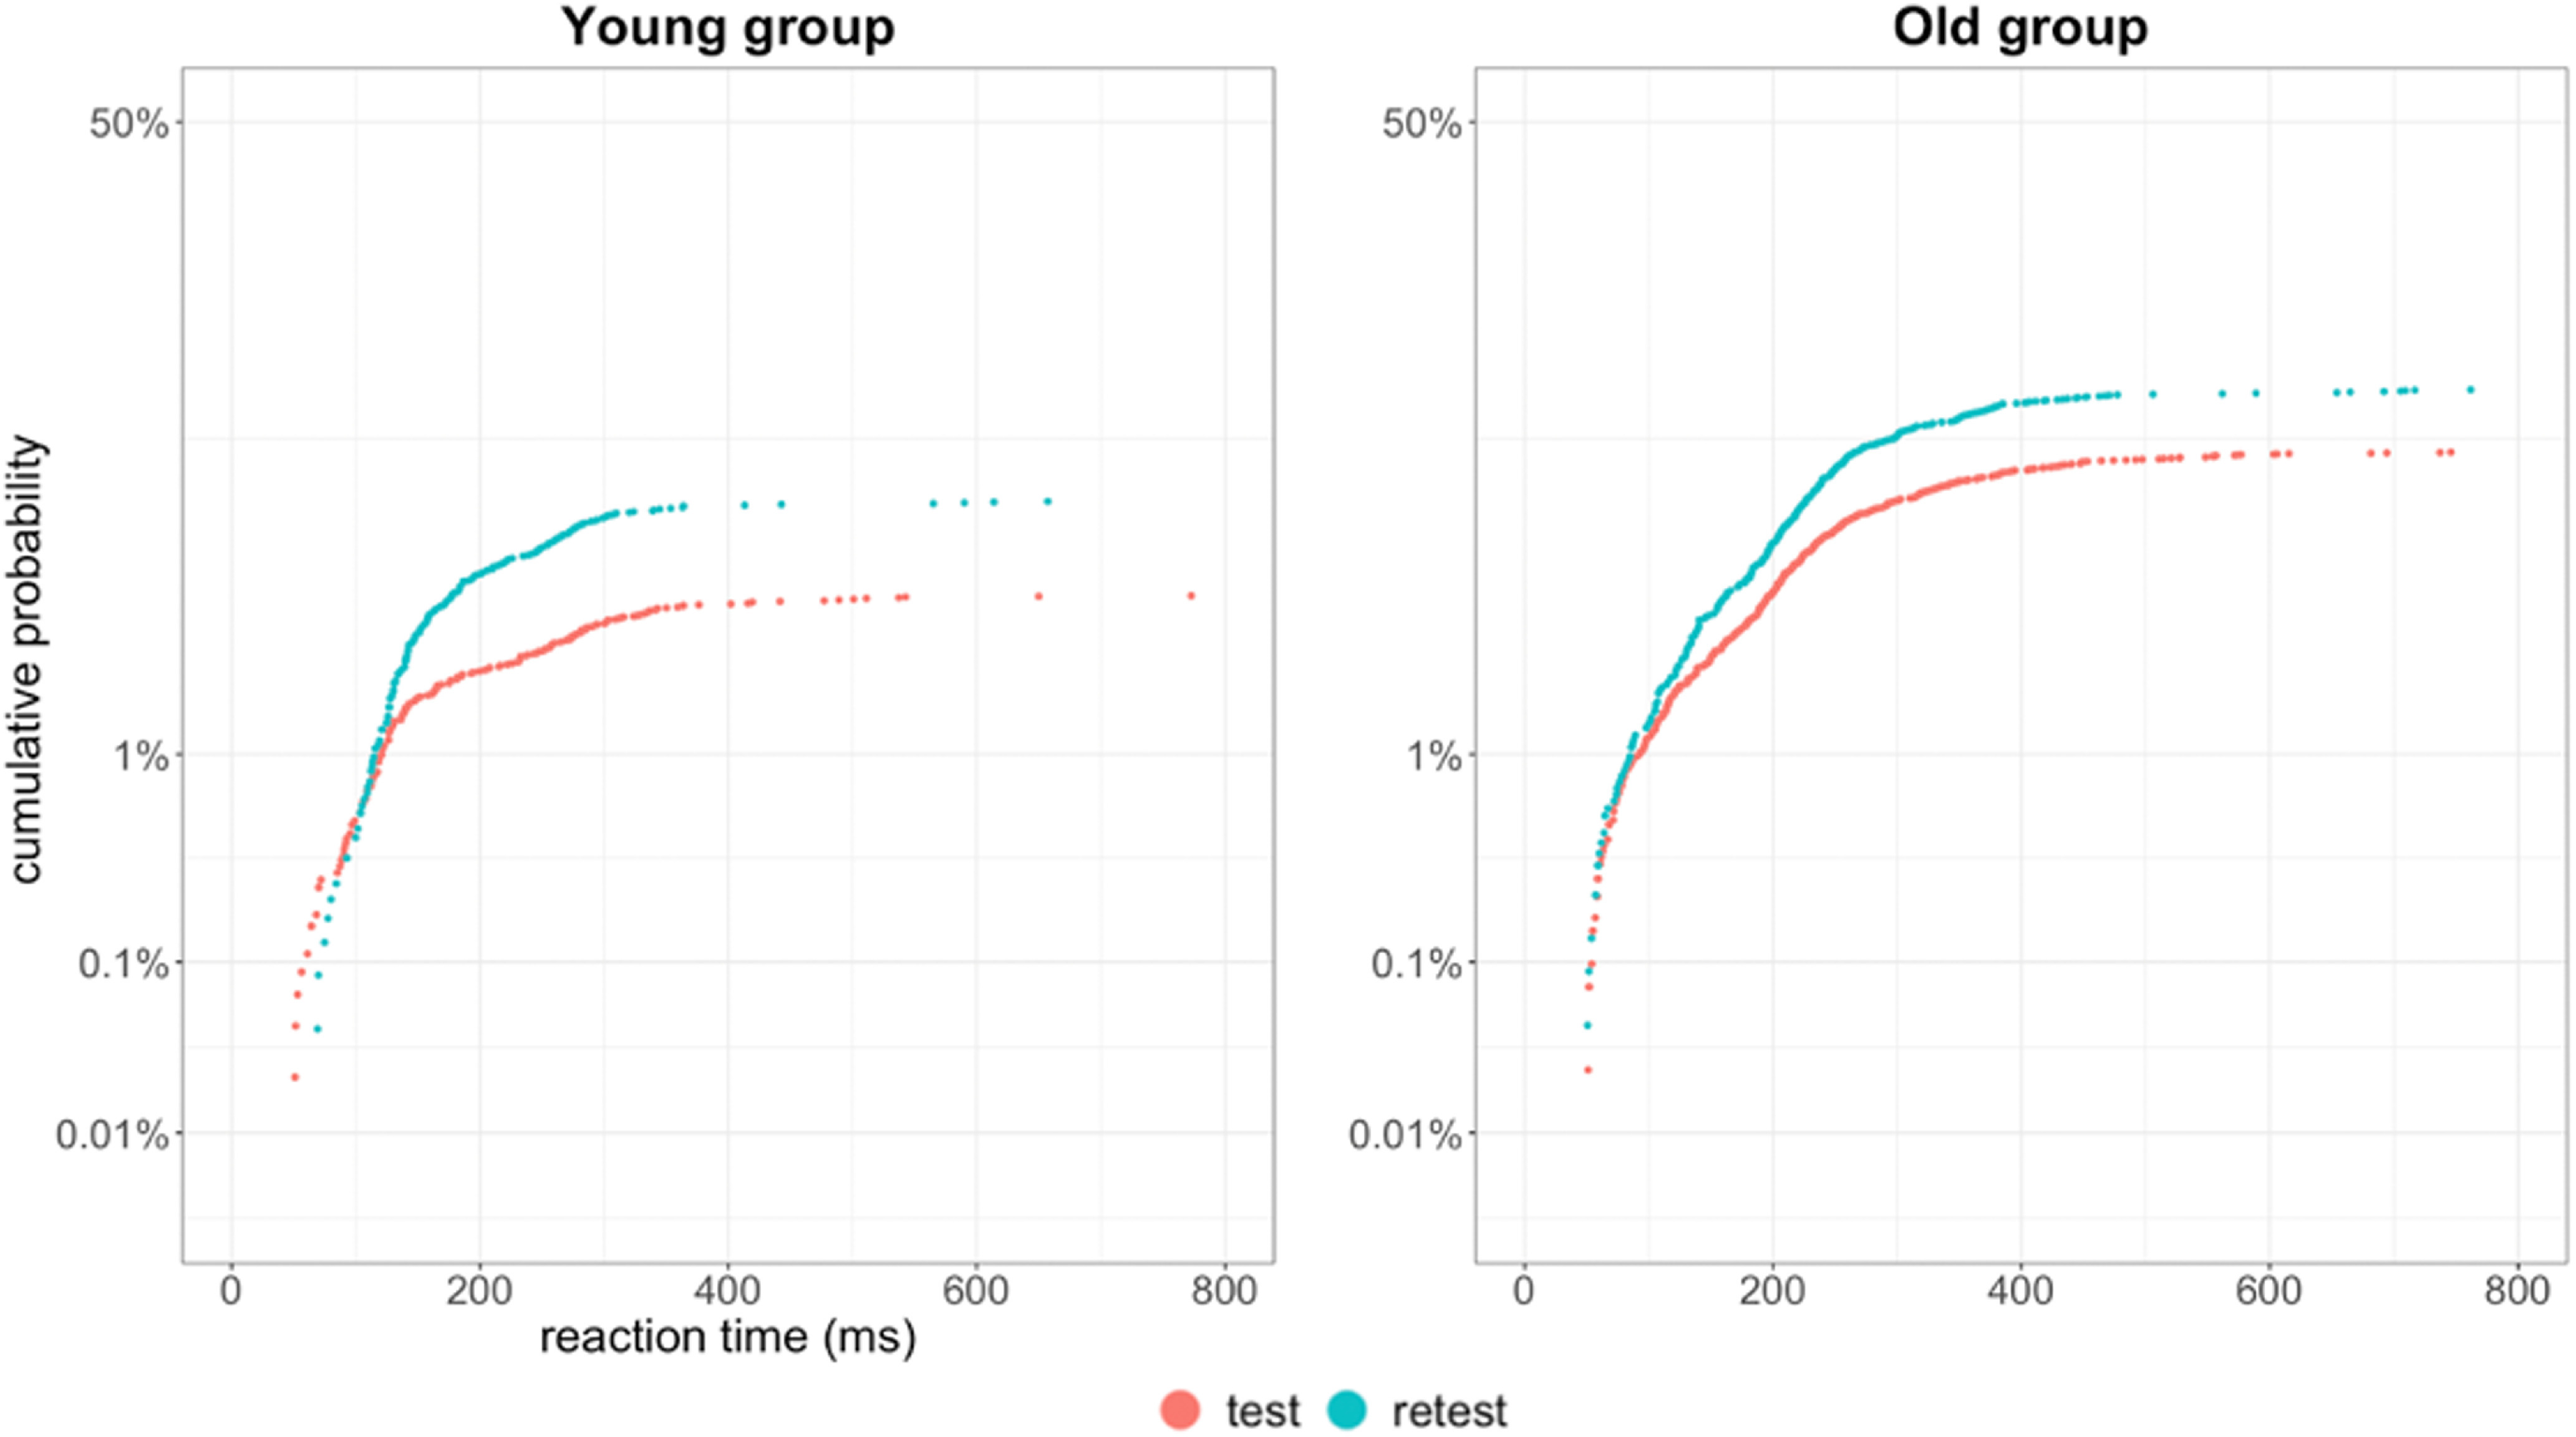
Reciprobit plots for error rate in the antisaccade trials, comparison for the young and old group, for test and retest. Error responses are plotted as a cumulative proportion of the total number of trials.